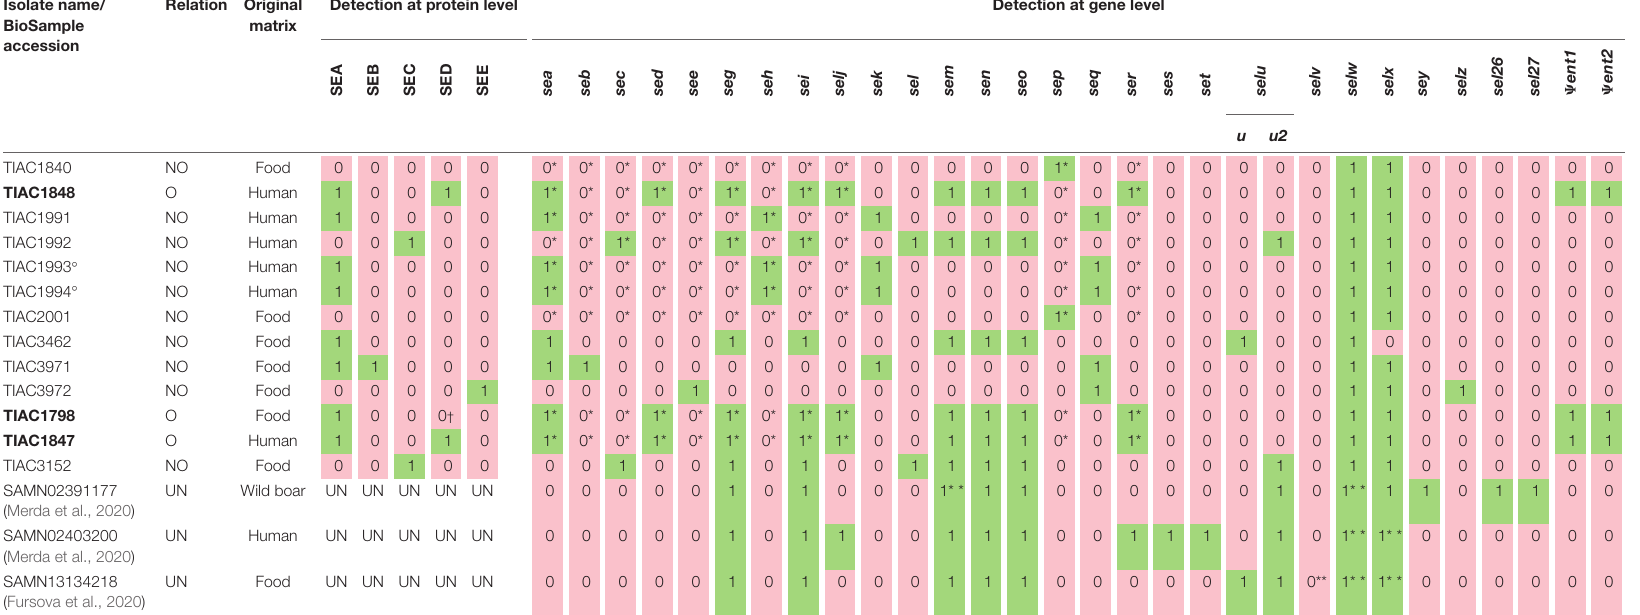
TABLE 1 | Characteristics of the selected in-house isolates and isolates for which WGS data were publicly